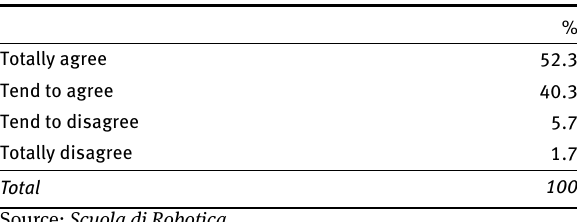
Table 2: The diffusion of robots will save people time and energy.